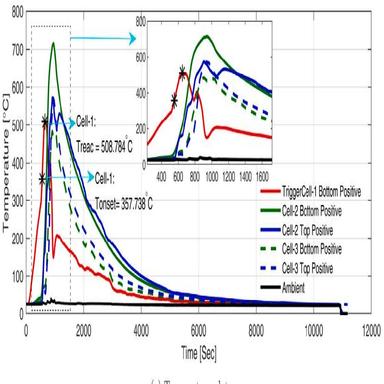
Overheating test of battery module with ceramifiable silicone rubber (1.5 mm) thermal barrier.